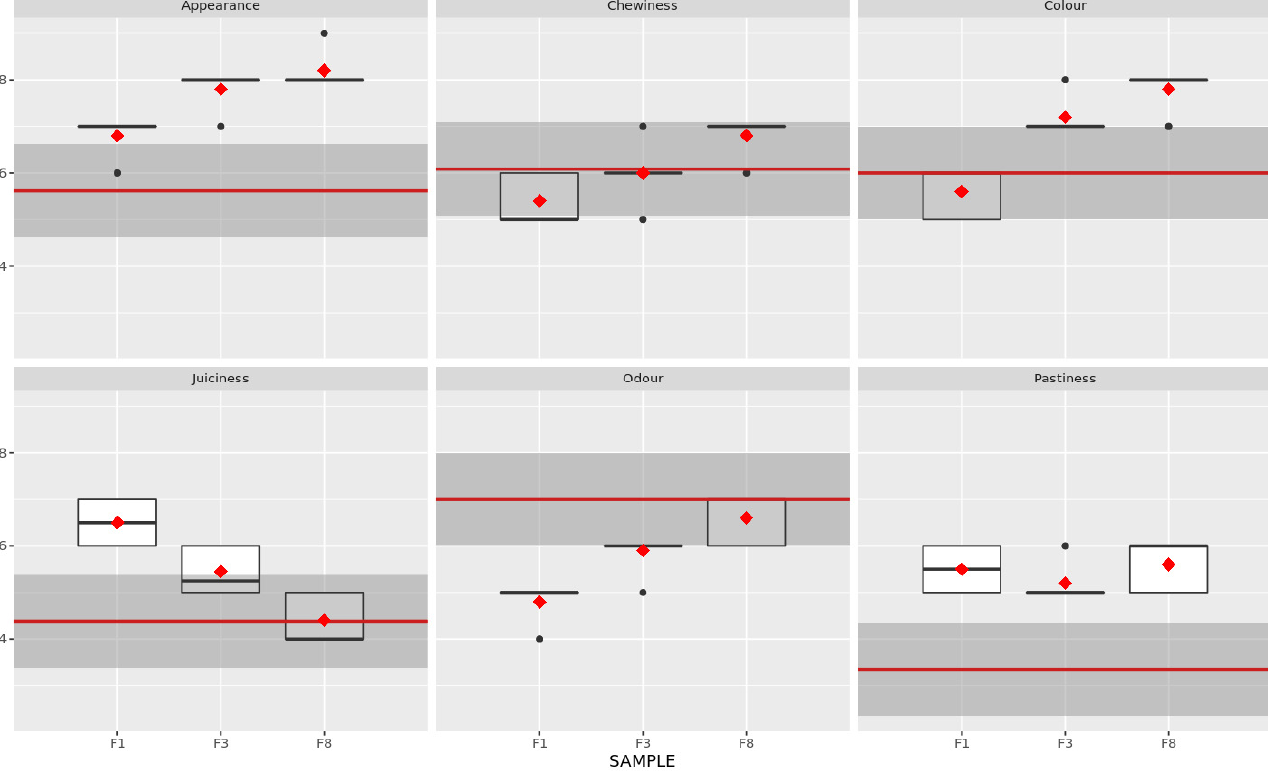
Figure 6. Boxplots for the attributes assessed for each sample (F1, F3 and F8) compared to the commercial sample QDA (horizontal red line). Dark grey area represents QDA values ± 1. Red dots represent the average of each panellist; black dots represent the outliers.